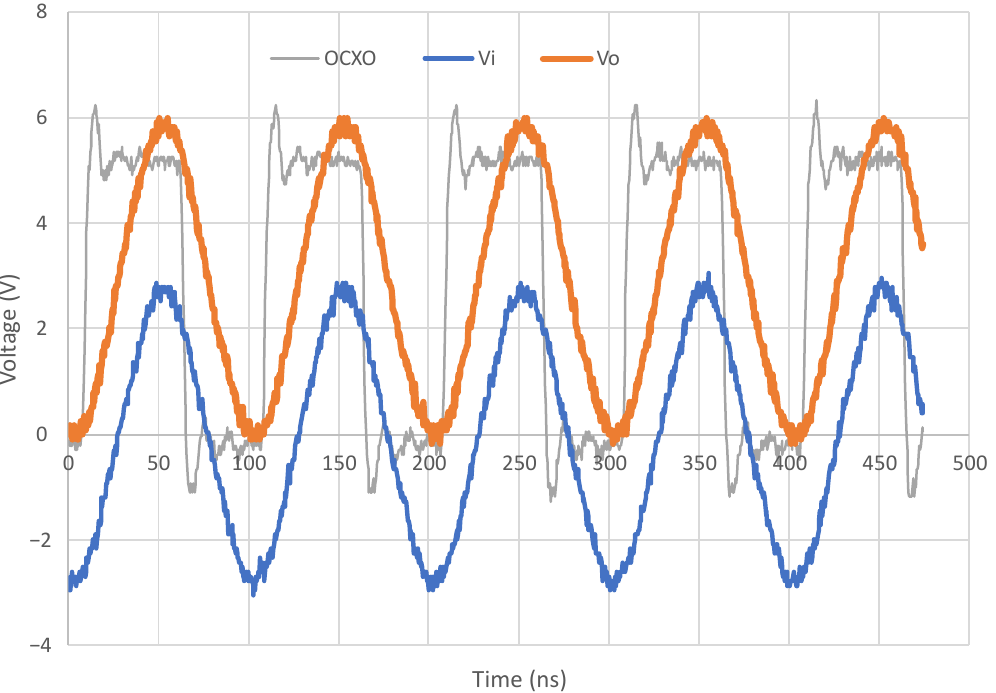
Figure 6. OCXO oscillator signal, counter output signal and clamper circuit output signal.